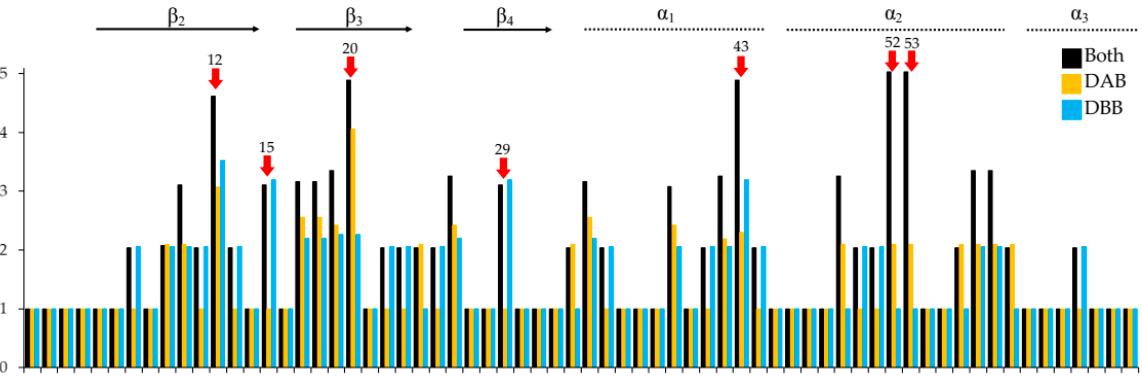
Figure 2. Wu–Kabat plot for the DAB and DBB clusters of Heermann’s Gull MHCIIB alleles. Red